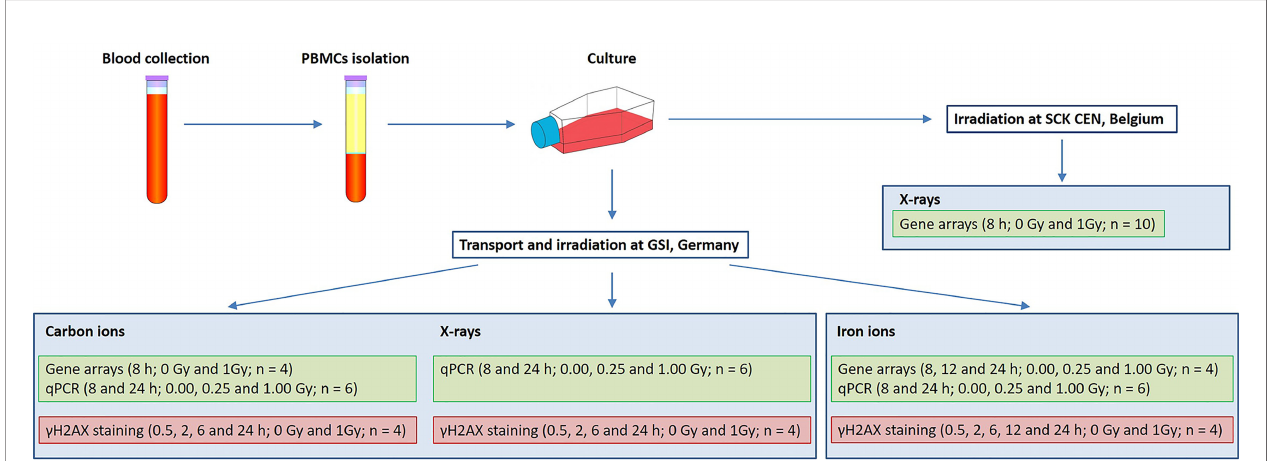
FIGURE 1 | Experimental setup. Samples listed in the same blue box were irradiated